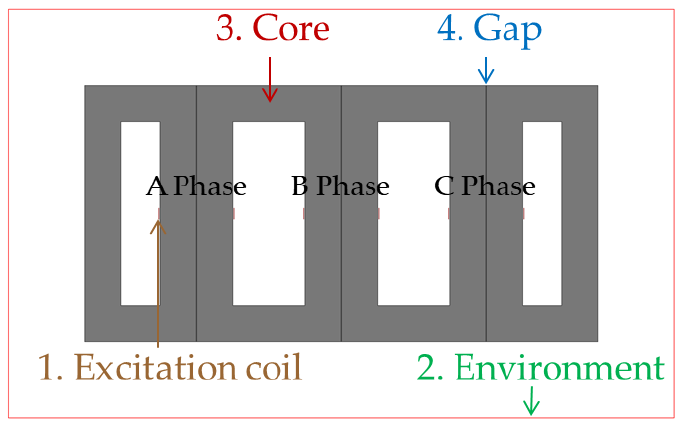
Figure 2. 2D simulation model diagram. Table 2. Materials of the simulation model.